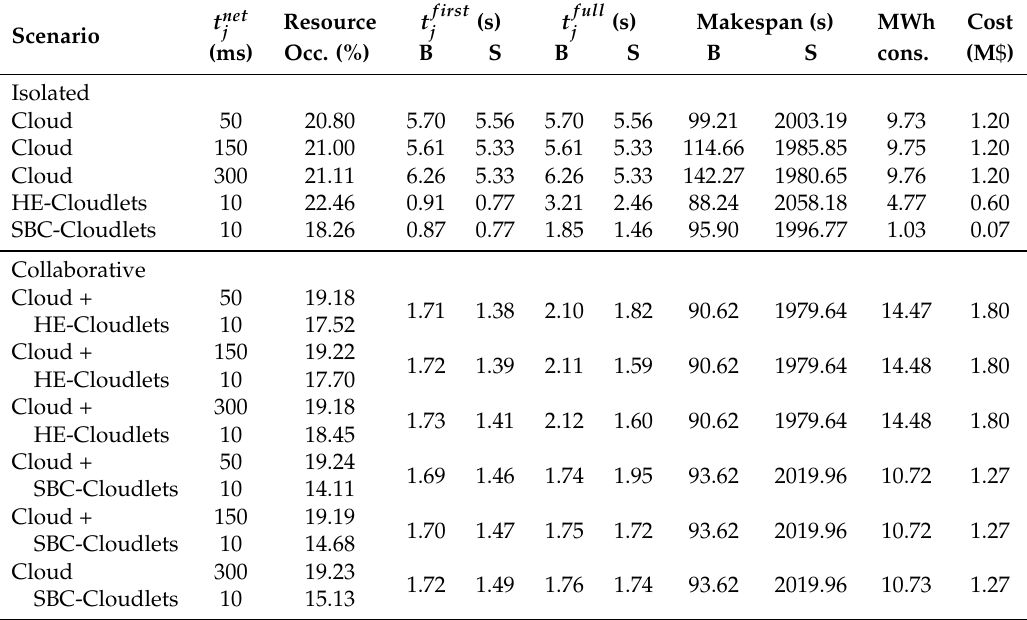
Table 5. Performance, energy consumption and costs results for each scenario for data-intensive workloads. t net represents the network delay, while t first and t full represent the time a job spends in j j j queue until its first task and its last task is scheduled, respectively. B means batch jobs while S means service jobs. To compute acquisition costs, we took average Dell PowerEdge R640 server and Raspberry Pi 3 prices, 2500 and 35 dollars,